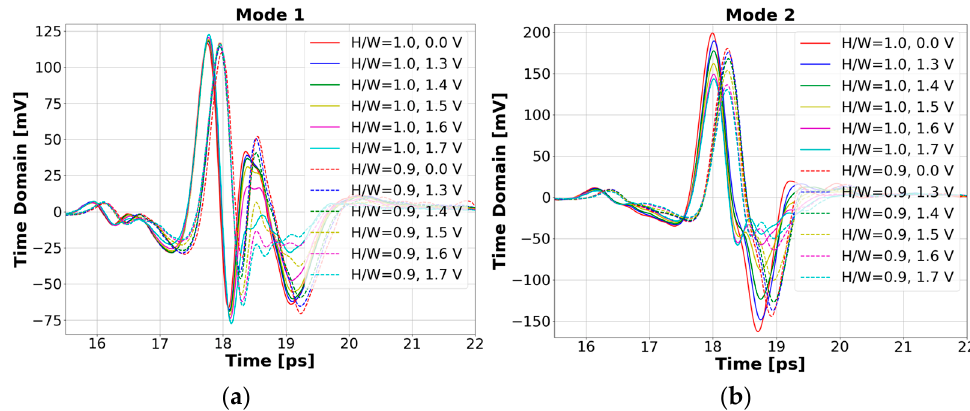
Figure 7. THz time-domain waveforms of two metamaterials with different aspect ratios depending on the voltage applied to the heater in ( a ) mode 1 and ( b ) mode 2.